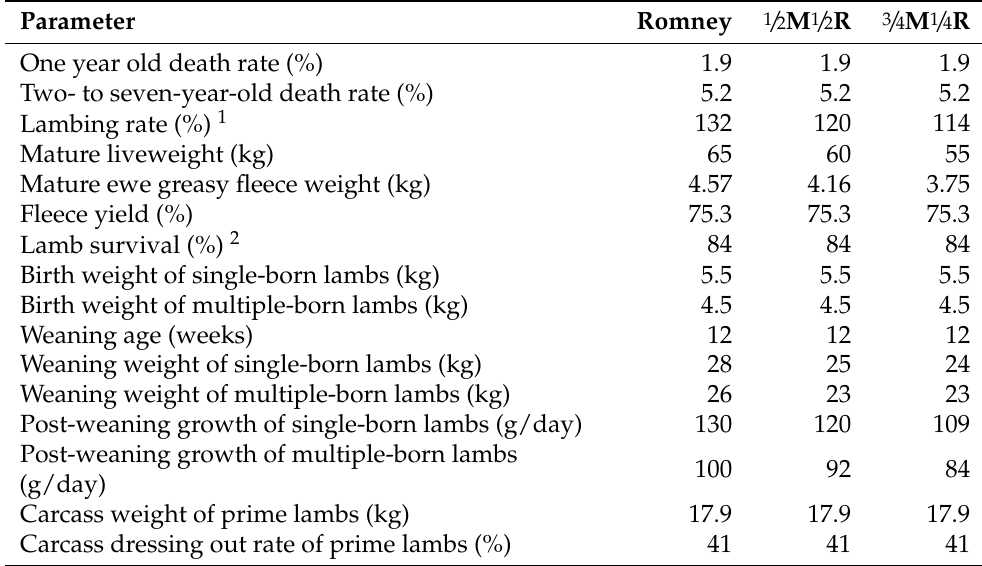
Table 2. Production parameters assumed in the analysis for ewe flocks of Romney, 1 / 2 Merino 1 / 2 Romney, and 3 / 4 Merino 1 / 4 Romney breeds, adapted from [4,5].